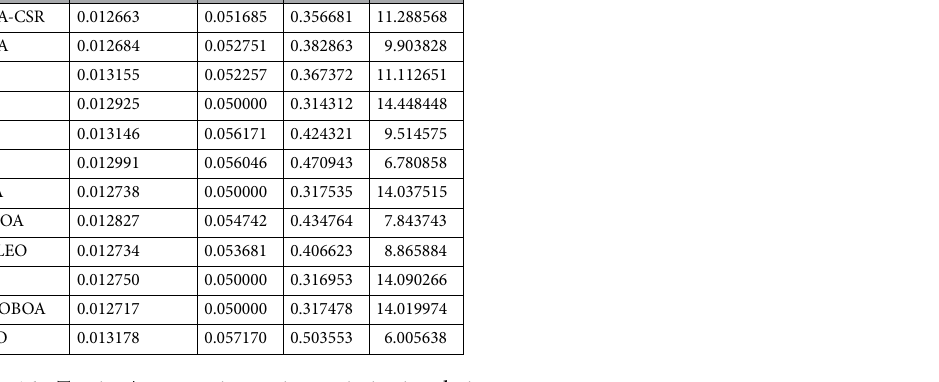
Table 16. Tension/compression spring optimization